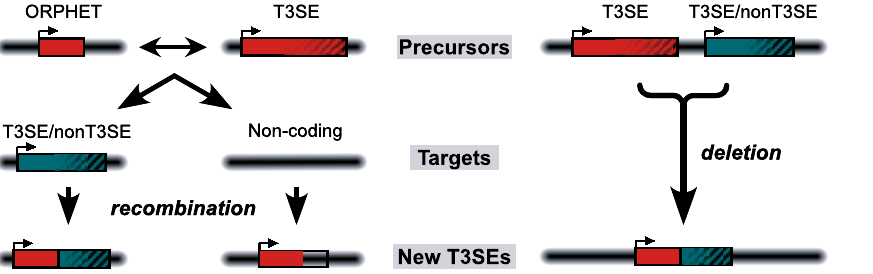
Figure 1. Proposed Mechanisms of Terminal Reassortment ORPHETs containing the appropriate regulatory and secretion signals may evolve independently or be derived from another effector. ORPHETs can be mobilized and integrated randomly into the genome, capturing either an existing gene or a non-coding region and thereby instantaneously creating a new chimeric effector. Alternatively, deletions downstream of an N-terminal secretion signal may also result in the formation of a new fusion protein. DOI: 10.1371/journal.ppat.0020104.g001